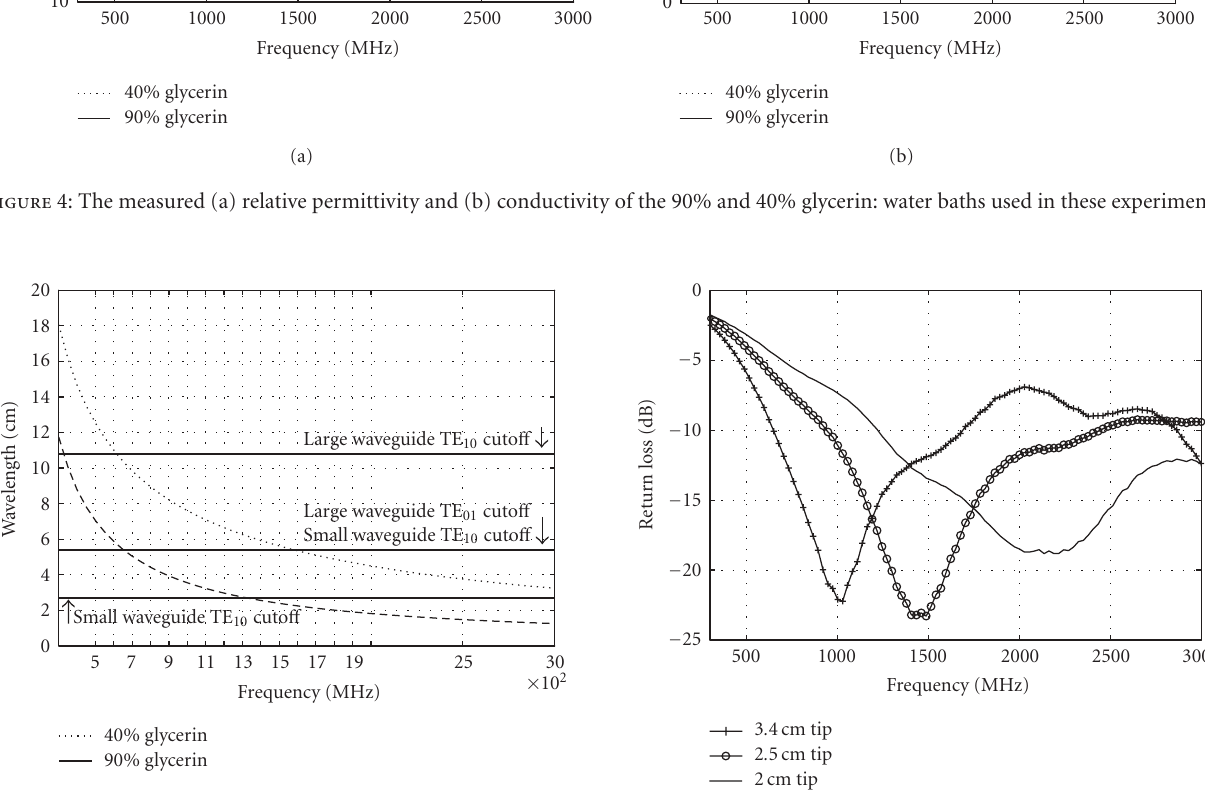
Figure 6: Measured return loss of the 2.0, 2.5, and 3.4cm length monopole antennas in the 90% glycerin: water bath as a function of